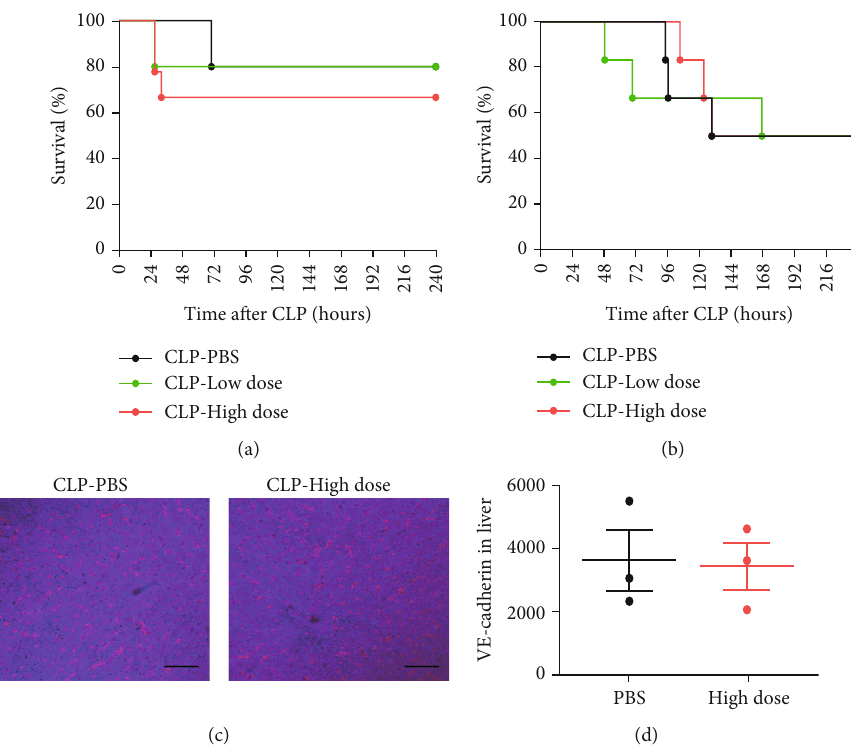
Figure 7: Genetic de fi ciency of NLRP3 or caspase-1 abrogated the damaging e ff ects caused by high dose of HNP-1 during sepsis progression. Nlrp3 -/- mice and Casp1 -/- mice were intraperitoneally administered a high dose of HNP-1 (10 mg/kg body weight), a low dose of HNP-1 (0.5mg/kg body weight), or PBS 6 hours after CLP. (a, b) Survival of Nlrp3 -/- mice (a) and Casp1 -/- mice (b) over time was monitored. In (a), n = 9 mice for the high-dose group, and n = 5 mice for the low-dose group and for the PBS group. In (b), n = 6 mice for each group. (c, d) Representative images (c) and comparisons of VE-cadherin abundance (d) in the liver of Casp1 -/- mice administered a high dose of HNP-1 or PBS at 48 hours after CLP is shown. The results presented are the means ± SEMs of 3 mice in each group. Scale bars, 50 μ